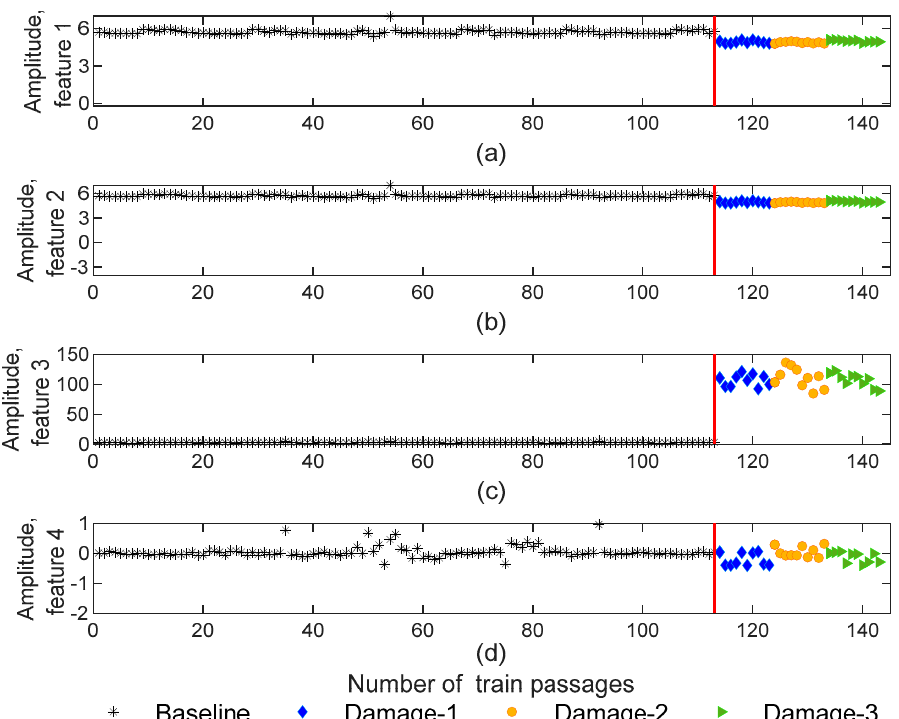
Figure 11. PCA—feature extraction for all 143 baseline and damage scenarios for accelerometer 3: ( a ) amplitude for feature 1, ( b ) amplitude for feature 2, ( c ) amplitude for feature 3, ( d ) amplitude for feature 4.